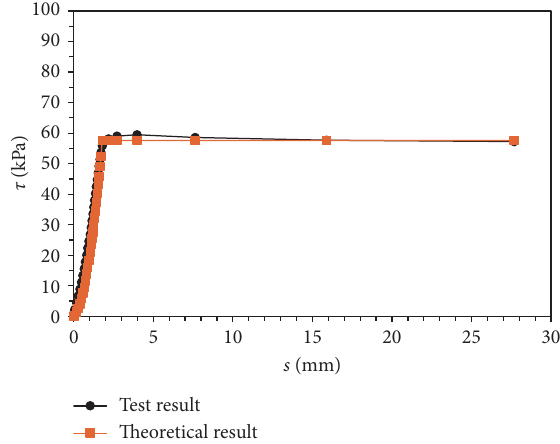
Figure 20: Comparison between test result and theoretical result of P-1.